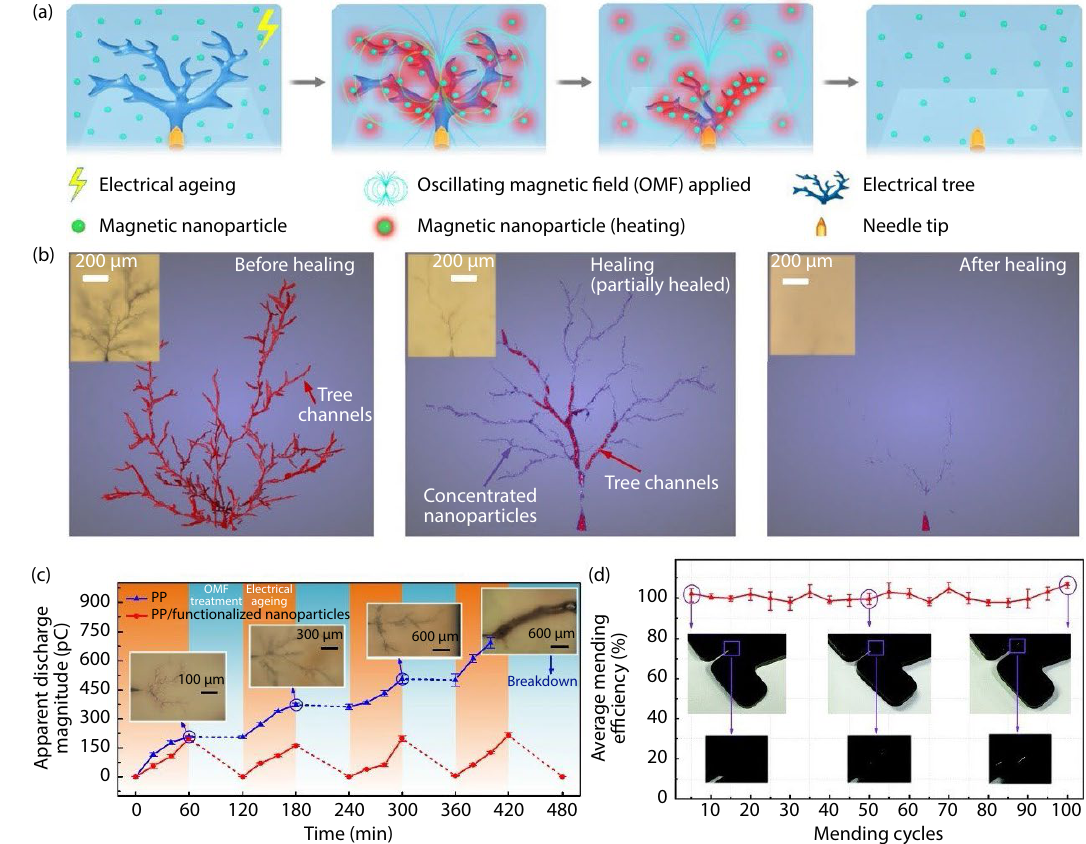
Fig. 17 Defect-targeted self-healing insulating materials. ( a ) A schematic of healing electrical trees by incorporating superparamagnetic nanoparticles. When treated by an oscillating magnetic field, the nanoparticles will migrate toward tree channels and generate heat, leading to melting interdiffusion at the damaged site (re- printed with permission from ref. [54], © 2018 Springer Nature). ( b ) The reconstruction of electrical trees in polypropylene (PP) during self-healing process by com- puted micro-X-ray tomography (reproduced with permission from ref. [54], © 2018 Springer Nature). ( c ) Apparent partial discharge magnitude of PP specimens with and without magnetic nanoparticles during multiple aging-healing cycles (reprinted with permission from ref. [54], © 2018 Springer Nature). ( d ) Healing efficiency for mechanical damage in 100 cracking-healing cycles (reprinted with permission from ref. [211], © 2020 The Royal Society of